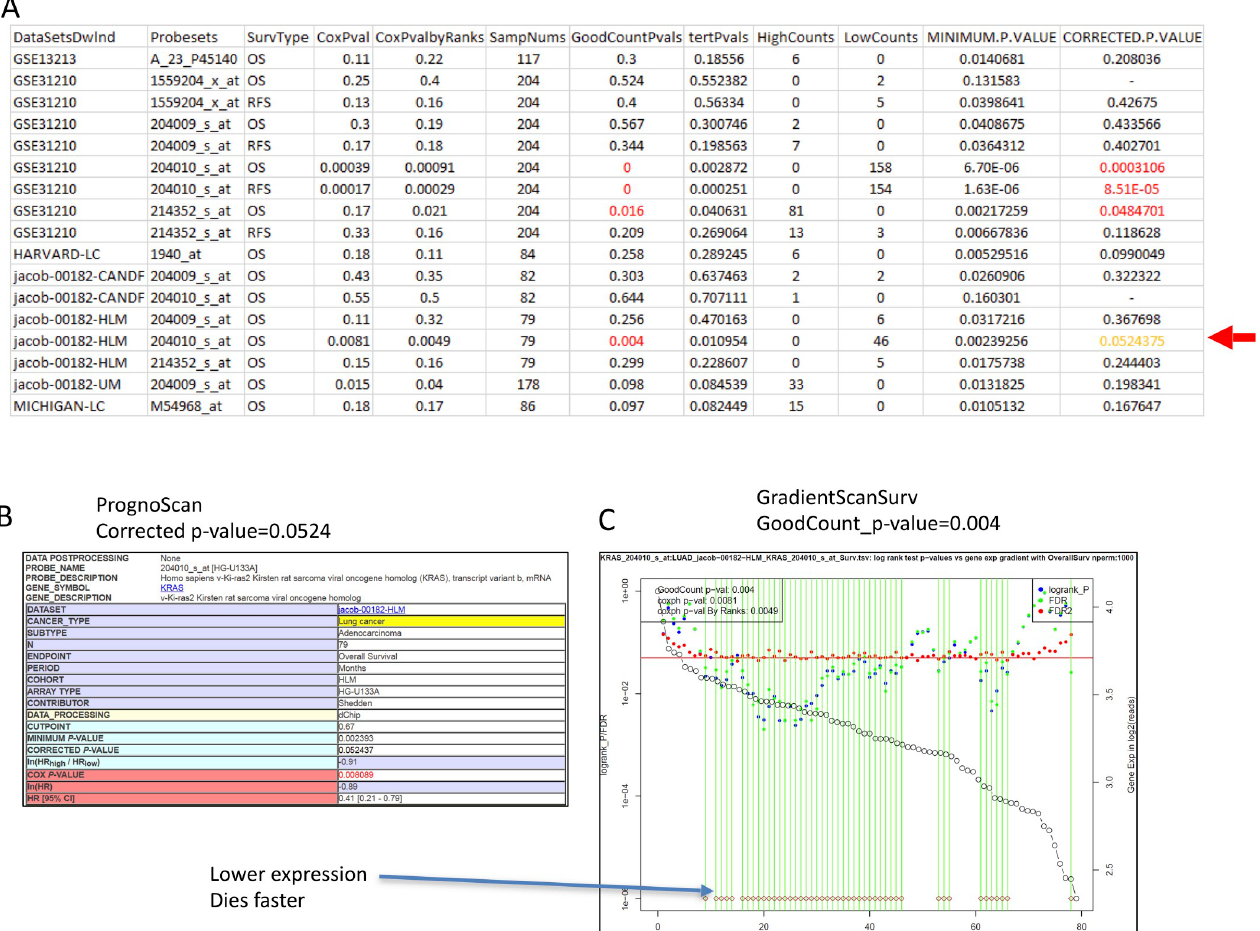
Fig 3. Comparison of GradientScanSurv with PrognoScan results for the KRAS gene in LUAD datasets downloaded from PrognoScan. (A). A joined table of GradientScanSurv results and direct results from the PrognoScan website for the KRAS gene in the same LUAD datasets. The red arrow indicates a dataset where GradientScanSurv called a significant association with GoodCountPval = 0.004, but PrognoScan barely missed the call with CORRECTED.P. VALUE = 0.0524 for dataset Jacob-00182-HLM with probeset 204010_s_at. (B). Screenshot of PrognoScan’s report for the dataset indicated by the red arrow in panel A. (C). GradientScanSurv gene expression gradient-based logrank p-values plot with GoodCountPval at 0.004 for the dataset indicated by the red arrow in panel A. See text for details.